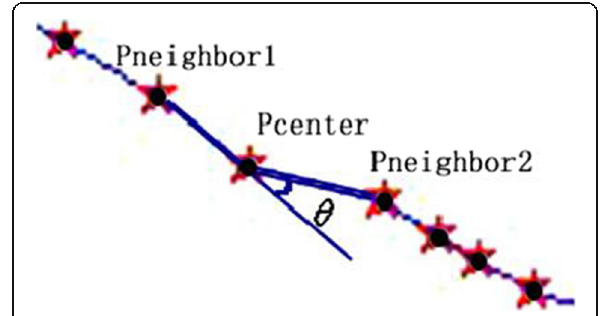
Fig. 6 Relation of adjacent vectors